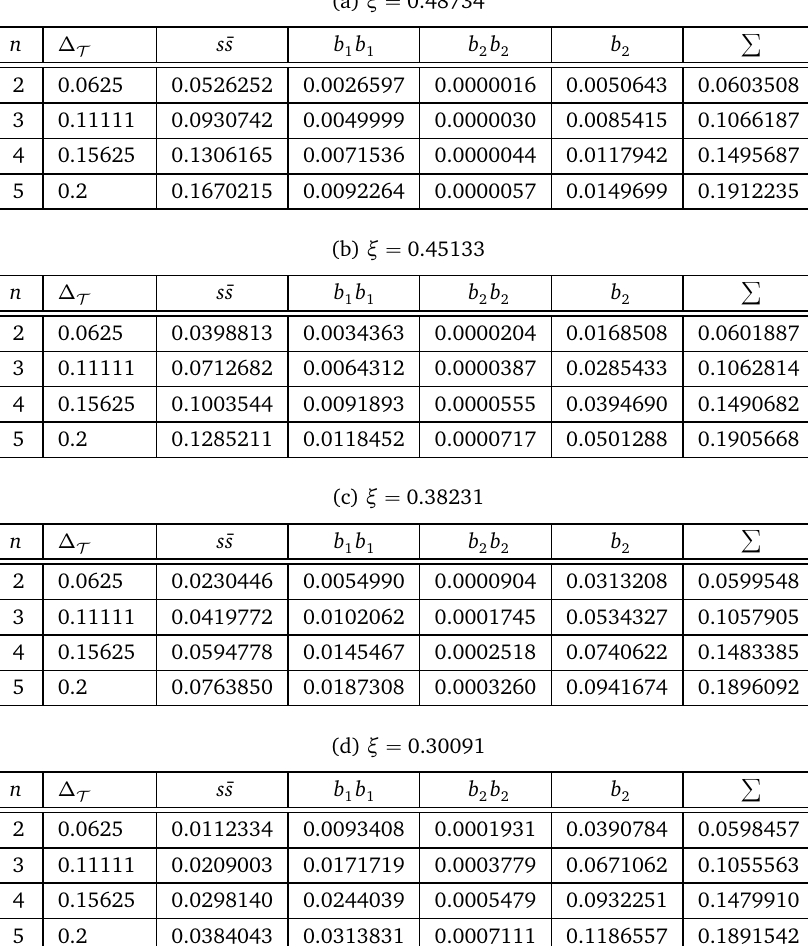
Table 2: One- and two-particle contributions to the ∆ sum rule for four values of ξ P p 1 , 1 ). It is interesting to observe how the breather contributions become larger 3 2 as ξ is decreased, sending the theory deeper into the attractive regime. For instance, in Table (d) the s ¯ s contribution accounts only for 20% of the value of ∆